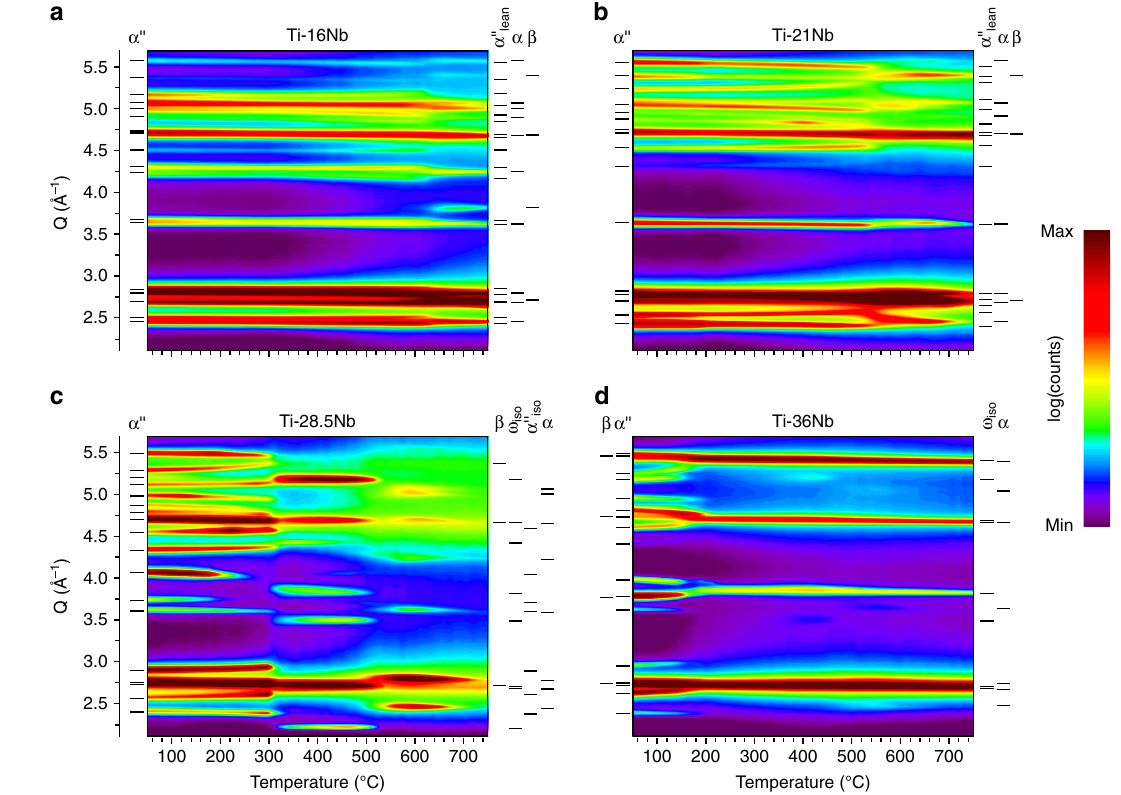
Fig. 2 Evolution of in situ synchrotron X-ray diffraction patterns. Results for a Ti – 16Nb, b Ti – 21Nb, c Ti – 28.5Nb and d Ti – 36Nb during heating at 10 °C min − 1 . On the left side of each panel the re fl ections of the phases present in the initial state at room temperature are identi fi ed. On the right side of each panel those formed during heating are identi fi ed. For each phase the markers indicate the re fl ection positions at their fi rst appearance (i.e. for the lowest